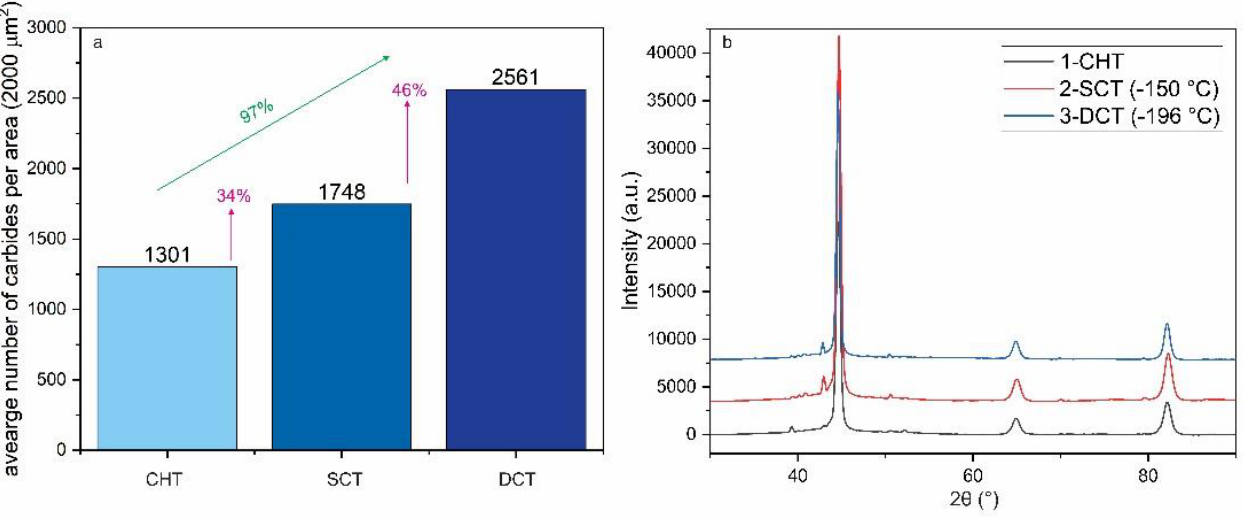
Figure 4. ( a ) the graph represents the average number of carbides per area (2000 µm 2 ), where at least 5 locations were measured per sample. ( b ) X-ray diffraction (XRD) of CHT (black line), SCT (red line) and DCT (blue line) samples.